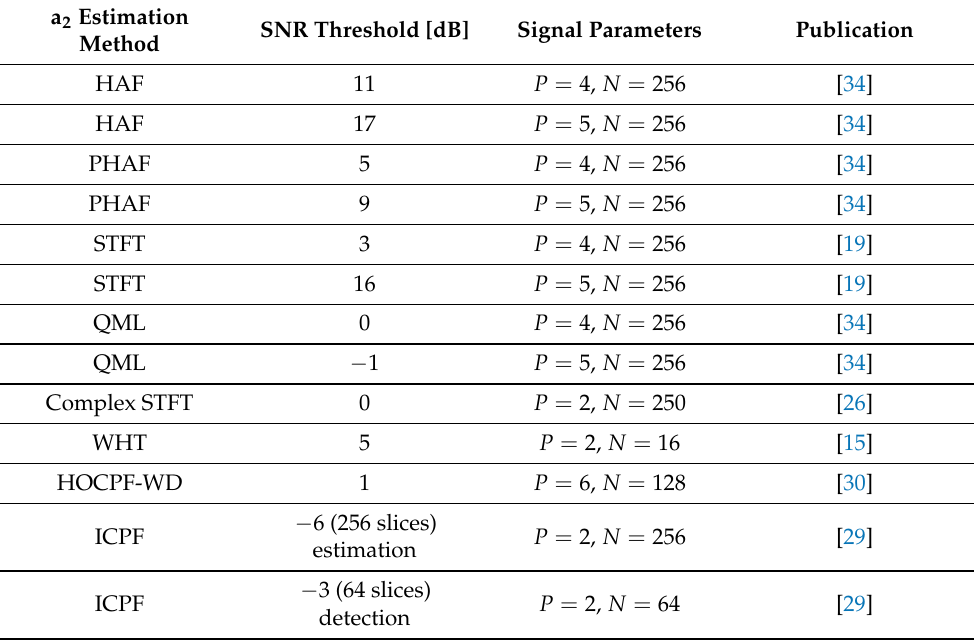
Table 1. Comparison of the SCPF-based estimator with other